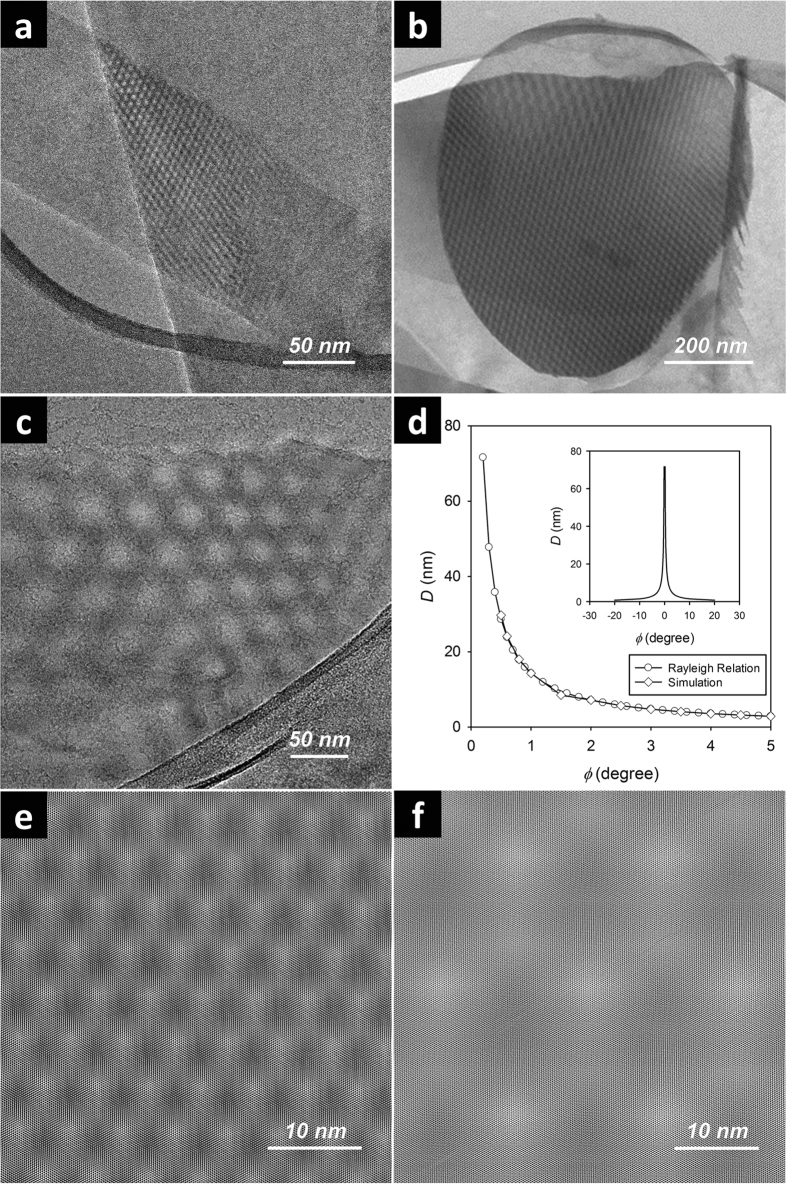
“Mesoscale” Moiré patterns of BNNS vdW superstructures: (a–c) low magnification TEM images of examples of Moiré patterns with various periodicities formed from large-area restacking of liquid exfoliated BNNSs; (d) dependence of Moiré periodicity (D) vs. the inter-nanosheet rotation angle (ϕ) at ϕ < 5° predicted by Eq. (1) (solid line) and simulation experiments (◊); the inset shows the entire periodic boundary (−30° < ϕ < 30°); (e,f) are simulated graphs of two restacked 10-layer BNNSs with rotation angles of 2.59° and 0.82°, corresponding to the calculated values from periodicities measured in (a,b), respectively.